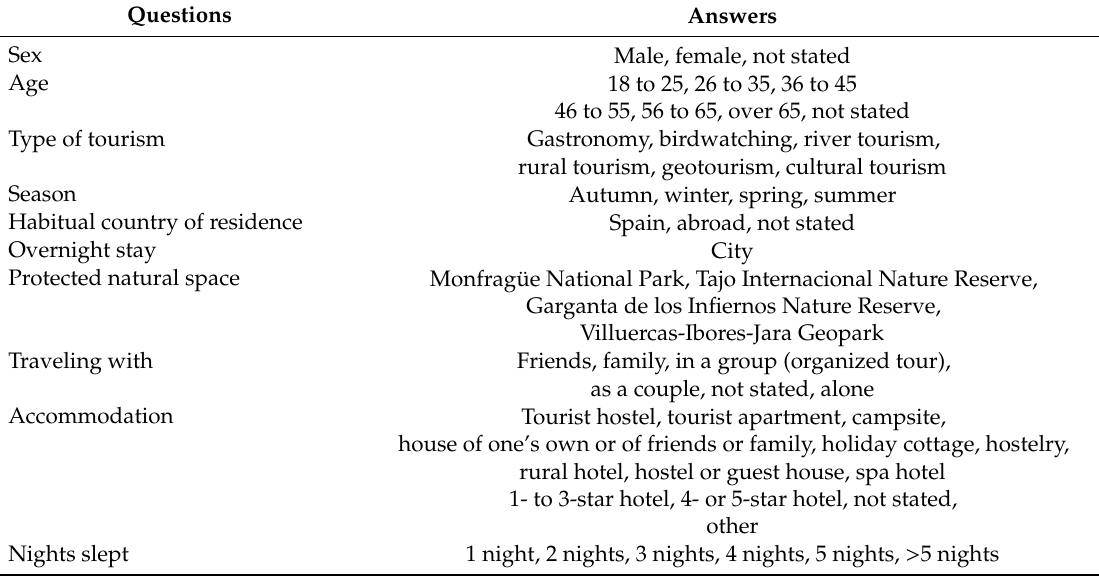
Table 2. Parameters of the